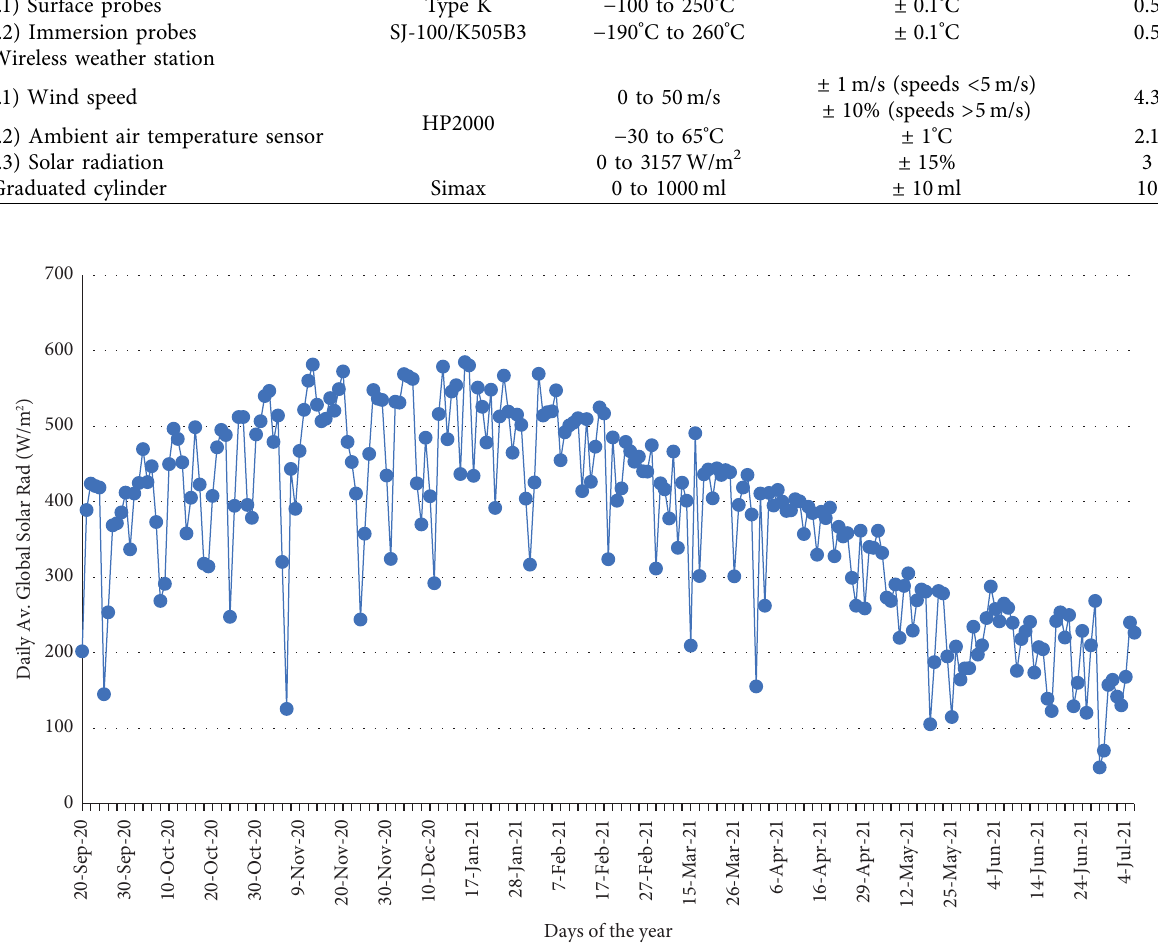
Figure 4: Daily average global solar radiation on a horizontal surface. Table 2: Various parameters of the vapour-based MSS-SS under low average